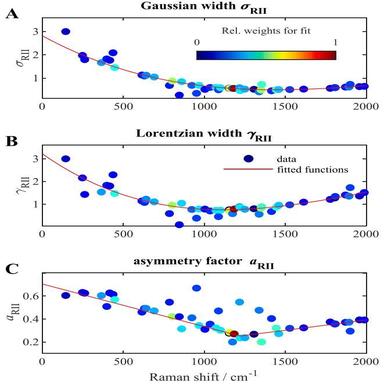
Core parameters of the RII: are A) Gaussian width σRII, B) Lorentzian width γRII, and C) asymmetry factor aRII relative to the Raman shift for S1 (25 μm slit, Ne). The single data points correspond to the peak parameters of the asymmetric Voigt peaks used to reconstruct the atomic emission spectrum. The data for σRII and γRII is fitted with 3rd-order polynomial functions, the aRII values with a piecewise linear function. The fits are weighted by the square root of the detected peak areas (color code). (For